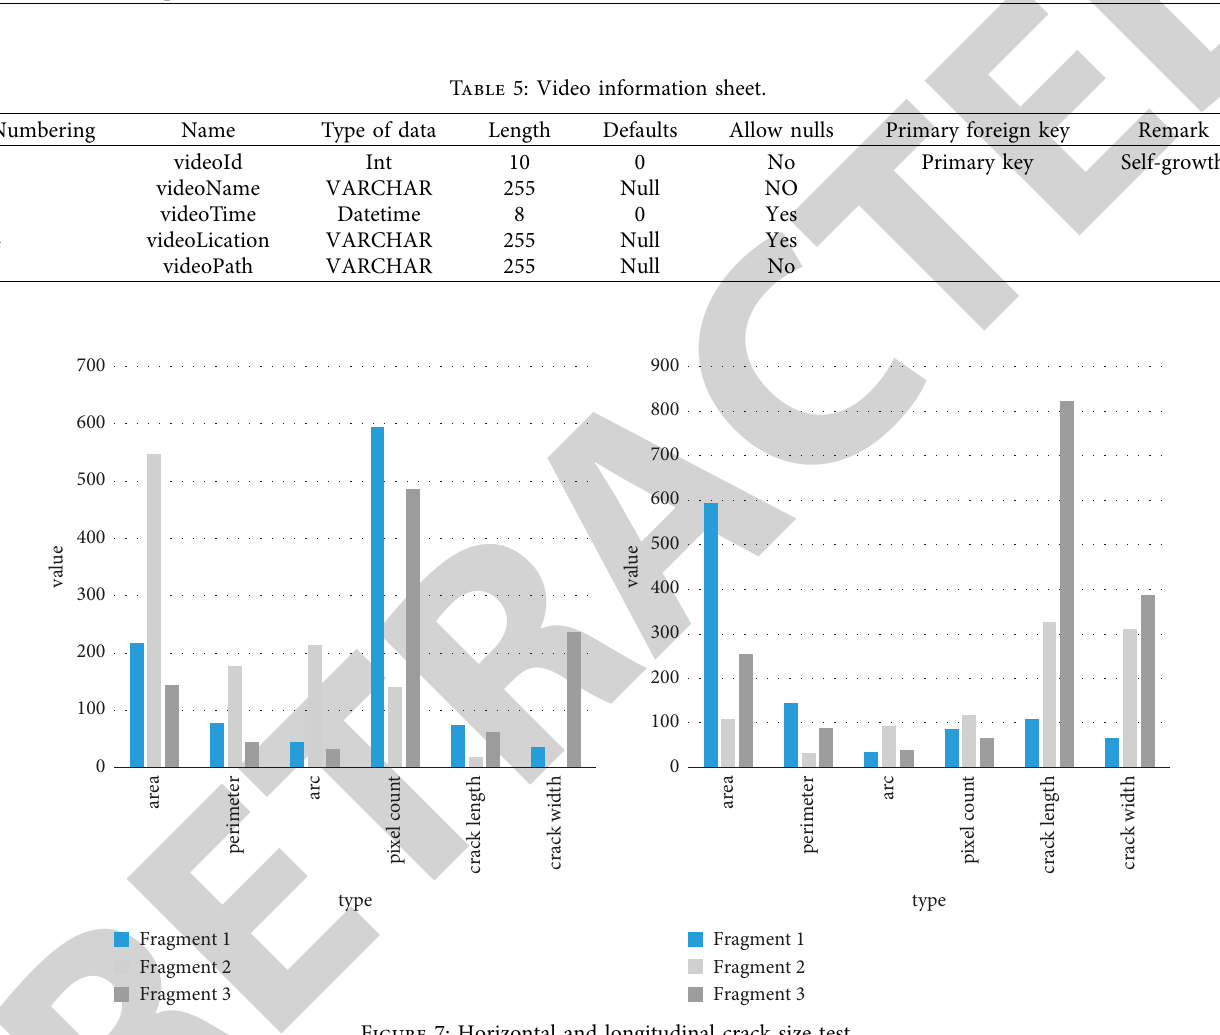
Figure 7: Horizontal and longitudinal crack size